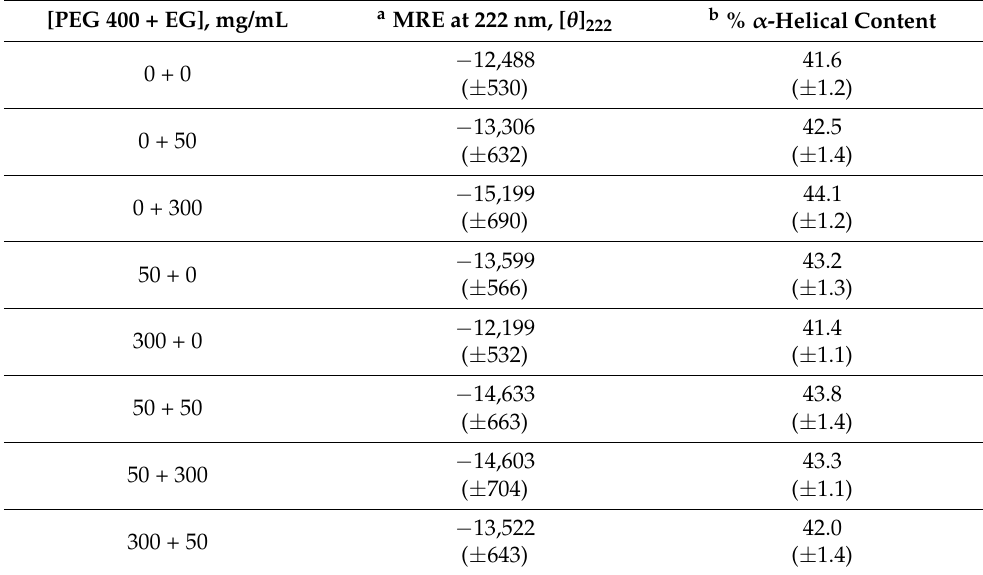
Table 1. Secondary structural content (%) of cyt c in the presence of various crowded mixture systems (PEG 400 + EG) measured at 222